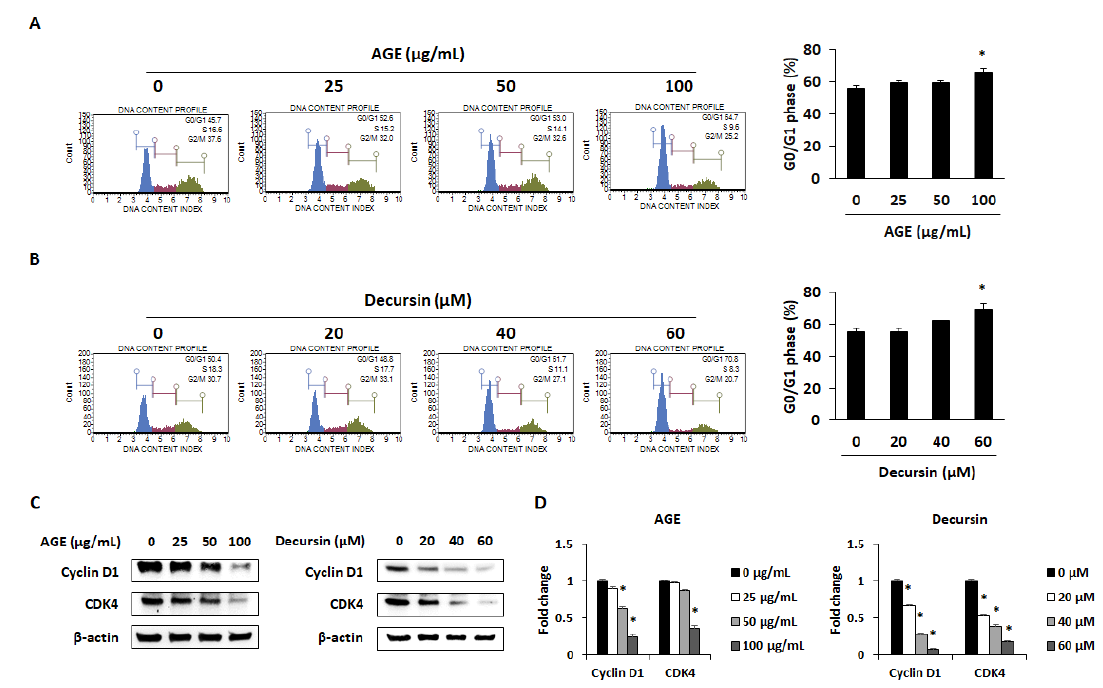
Figure 3. AGE and decursin induced G0 / G1 phase cell cycle arrest of pancreatic cancer cells. ( A , B ) Cell cycle phase distribution of PANC-1 cells after AGE ( A ) and decursin ( B ) treatment was analyzed by flow cytometry. ( C ) Protein expression of cyclin D1 and CDK4 was detected in AGE- and decursin-treated pancreatic cancer cells. ( D ) mRNA expression of cyclin D1 and CDK4 was determined by real-time RT-PCR. Data were analyzed from at least three independent experiments. * p < 0.05.